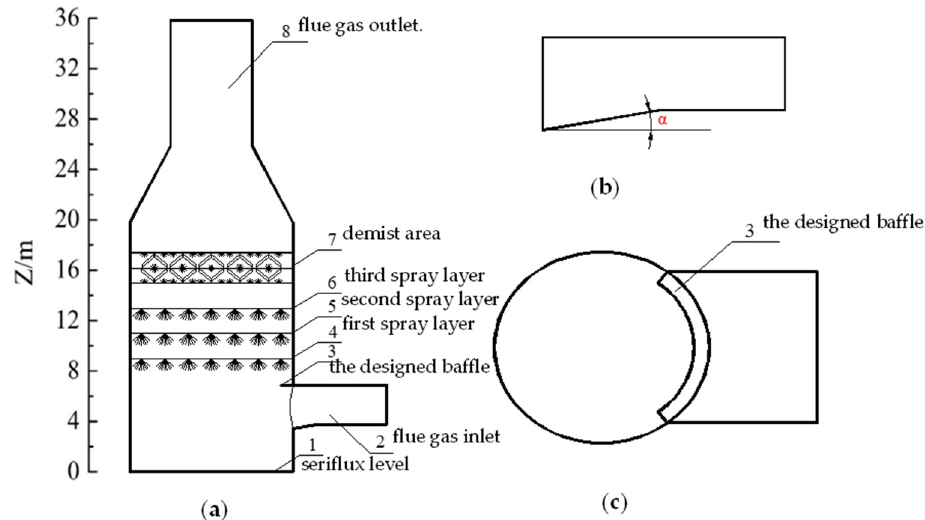
Figure 1. Diagrammatic sketch of the desulfurization spray tower; ( a ) tower structure; ( b ) flue gas inlet angle; ( c ) designed baffle in flue gas inlet. 1—seriflux level; 2—flue gas inlet; 3—the designed baffle; 4—first spray layer; 5—second spray layer; 6—third spray layer; 7—demist area; 8—flue gas outlet. Table 1. Basic parameters of the numerical simulation.